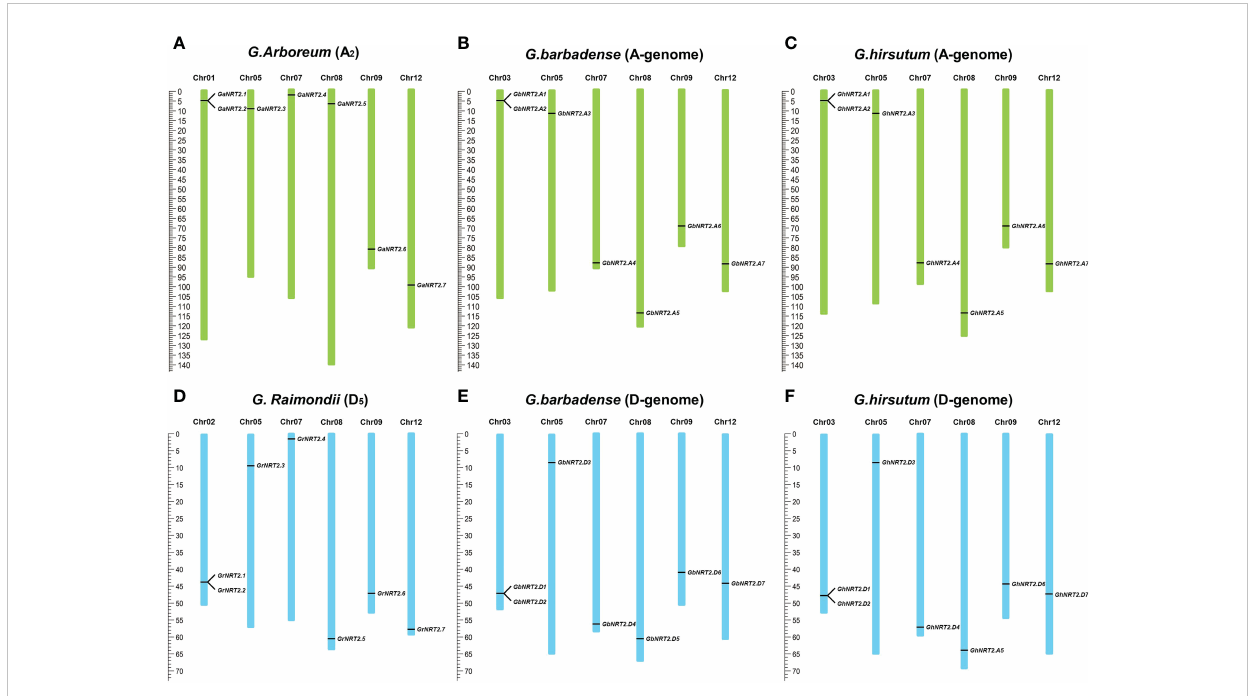
FIGURE 2 Chromosome distribution and duplication of GhNRT2s. (A) 7 GaNRT2s were mapped on 6 chromosomes in G.arboreum ; (B) 7 GbNRT2s were mapped on 6 chromosomes in G.barbadense (A-genome); (C) 7 GhNRT2s were mapped on 6 chromosomes in G.hirsutum (A-genome); (D) 7